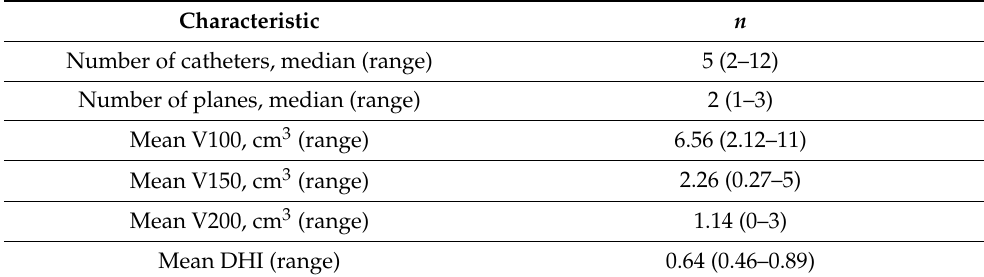
Table 2. Physical characteristics of brachytherapy.